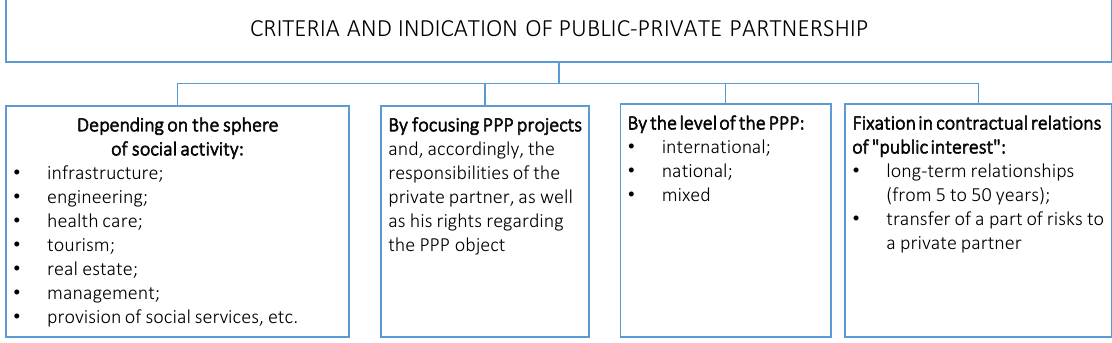
Figure 1. Public-private partnership criteria